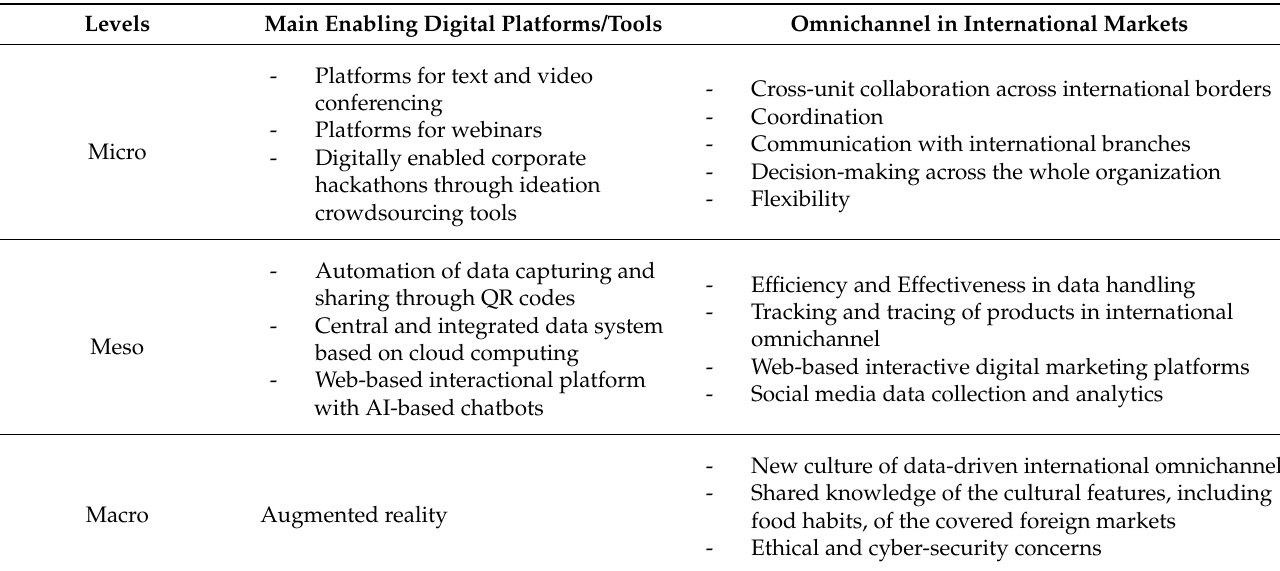
Table 1. An overview of